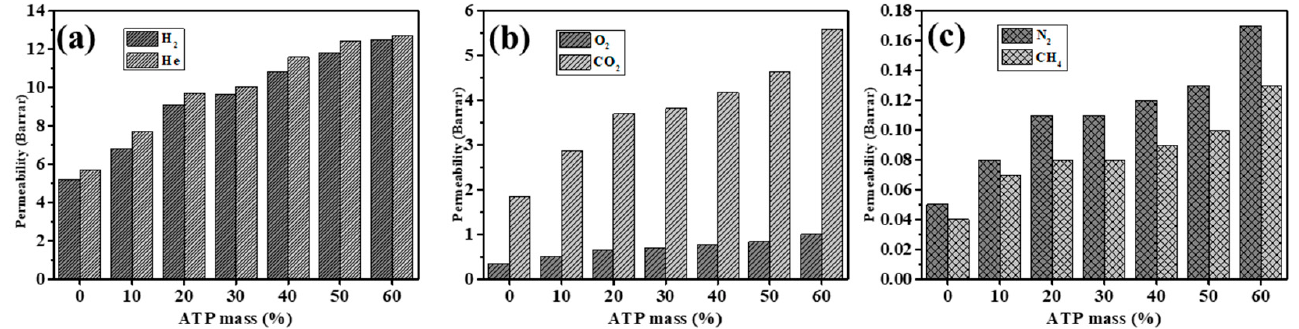
Figure 8. Gas permeability performance ( a ) H 2 , He, ( b ) N 2 , CH 4 , and ( c ) O 2 , CO 2 of PI/ATP composite membranes with different ATP content.